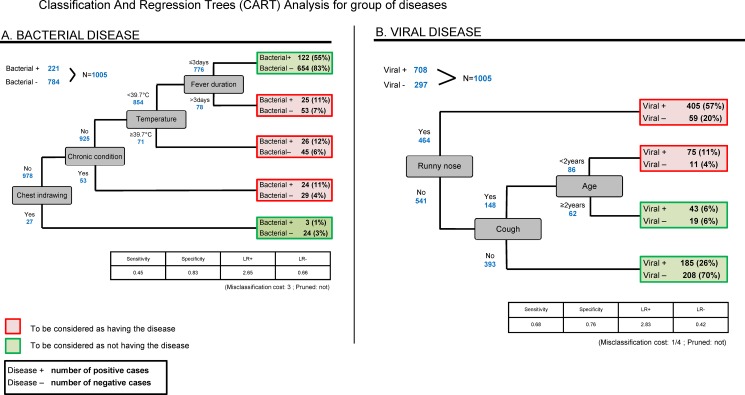
CART analyses for groups of diseases.Classification and regression trees analyses for groups of diseases. A. Bacterial disease; B. Viral disease.